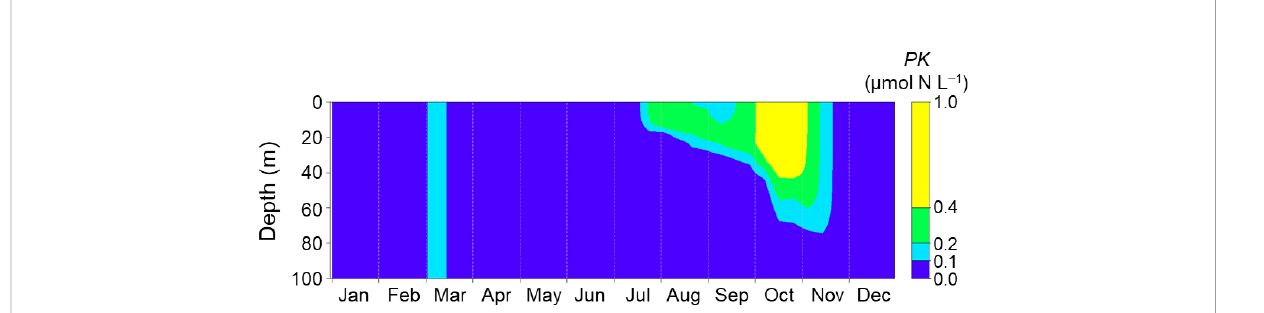
FIGURE 8 Seasonal changes of PK concentration simulated with the mean daily driving forces at Stn. A1 during 2003 – 2018. The biomass was initialized on day